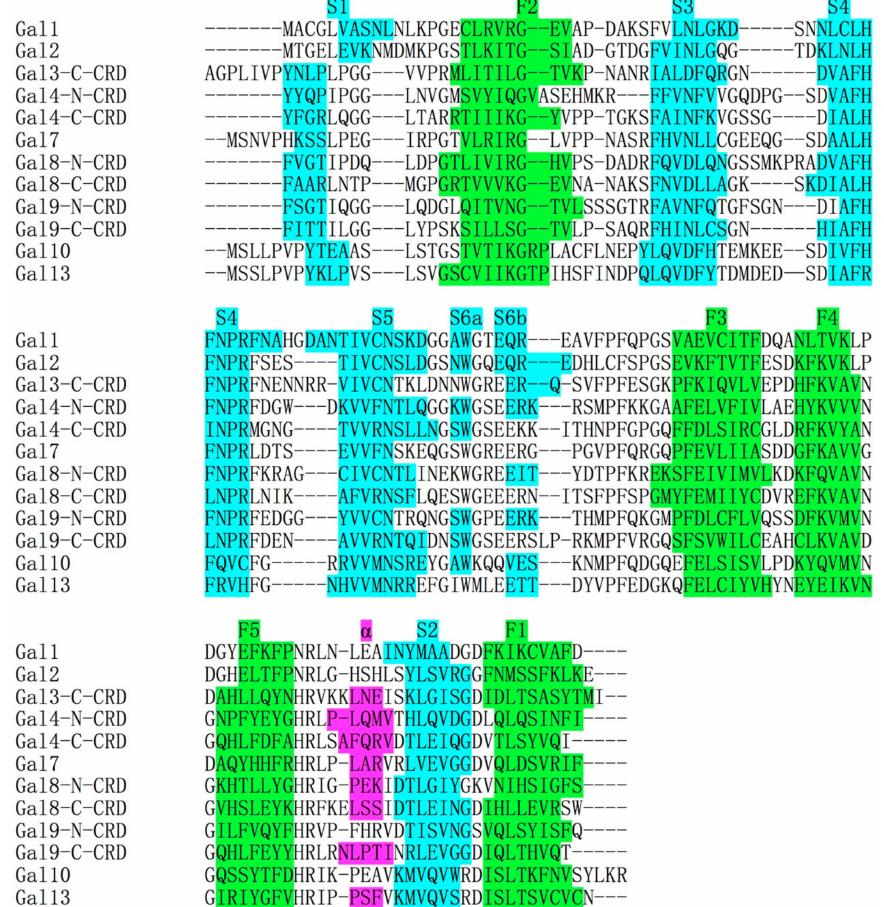
Figure 1. Amino acid alignment of carbohydrate binding domain (CRD) of several human galectins. Beta strands in S-face and F-face were colored by cyan and green, respectively. A small alpha helix (colored by purple) occasionally forms in several galectin CRDs. The primary structure of Gal-10 is homologous to the CRDs of other galectins. The alignment was generated by CLUSTAL 2.1. The primary structure of Gal-12 was not used in this alignment because the secondary structure of Gal-12 was not